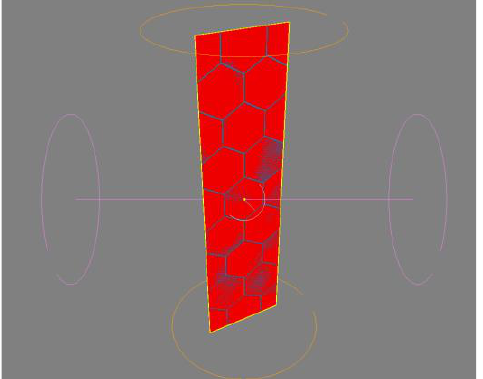
Figure 2. General view of the geometry of the computational domain.